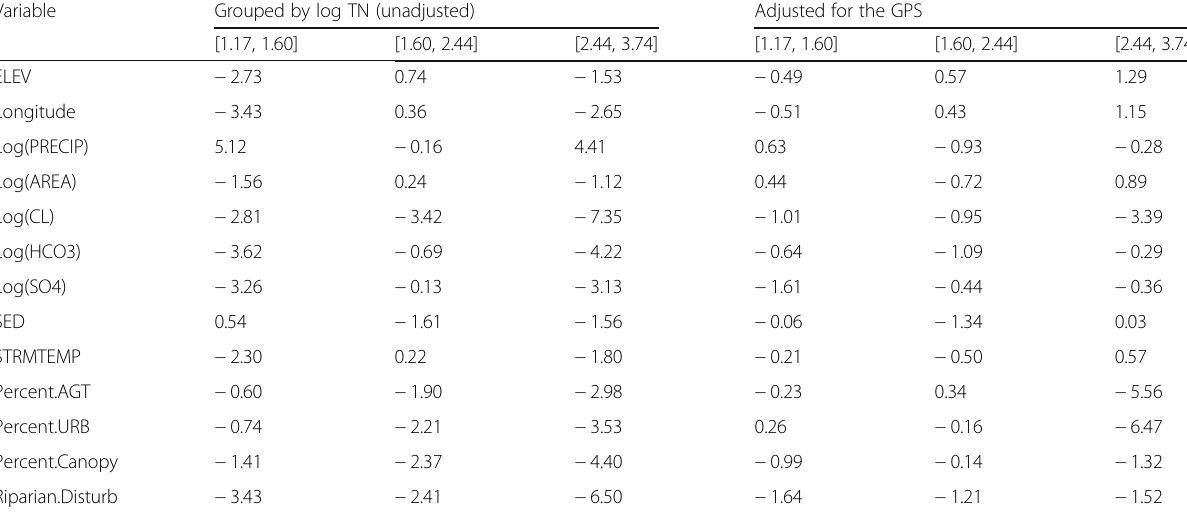
Table 4 Standardized mean differences between one group and the other two combined for the Forested Mountains ecoregion stratum